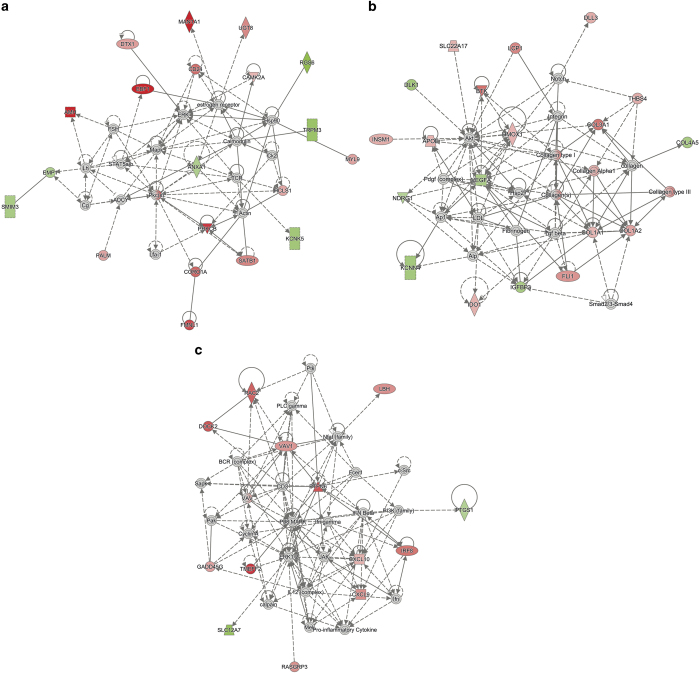
Differentially expressed genes between GBM100 and GBM3 and GBM0.2 tumours involved in (a) cellular development, (b) cancer and (c) cellular function and maintenance networks (red – upregulated in GBM3 and GBM0.2; green – downregulated in GBM3 and GBM0.2, fold change >2, P<0.05).